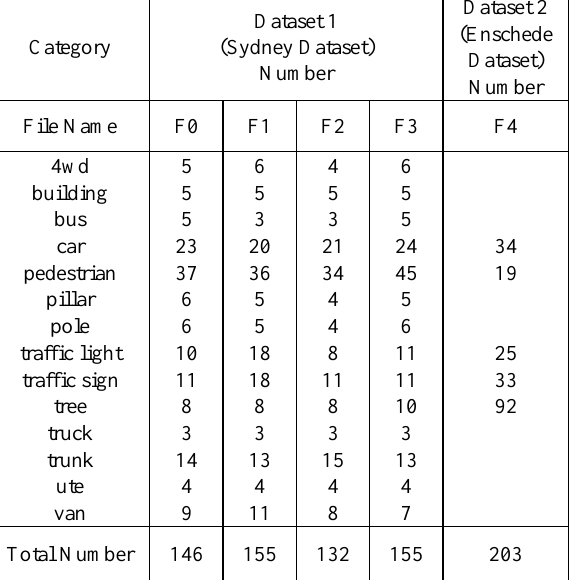
Table 1. The distribution of